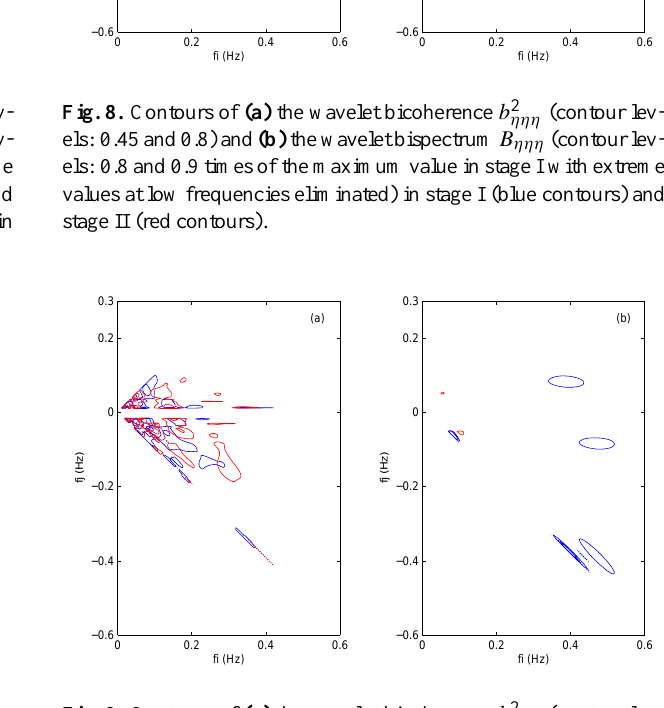
Fig. 7. Contours of (a) the wavelet bicoherence b 2 uuη (contour lev- els: 0.45 and 0.8) and (b) the wavelet bispectrum B uuη (contour lev- els: 0.5 and 0.7 times of the maximum value in stage I with extreme values at low frequencies eliminated) in stage I (blue contours) and stage II (red contours), respectively; all points on the black lines in (a) and (b) have coordinates summed to be 0.2Hz.